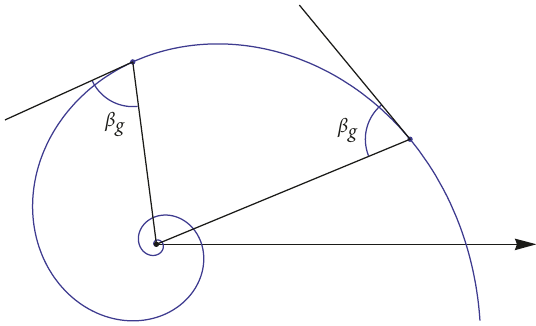
Figure 8: Arm-radius angle of the golden spiral.